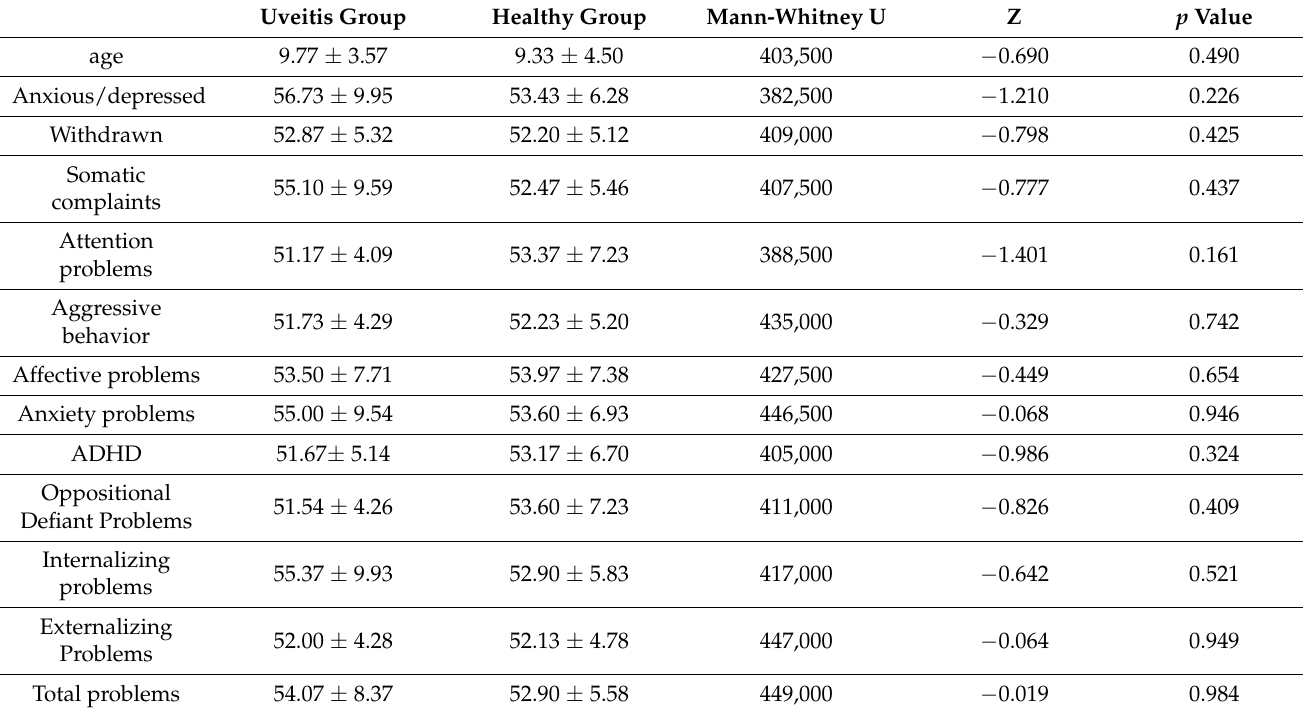
Table 2. Table 2. Differences scores between groups found in